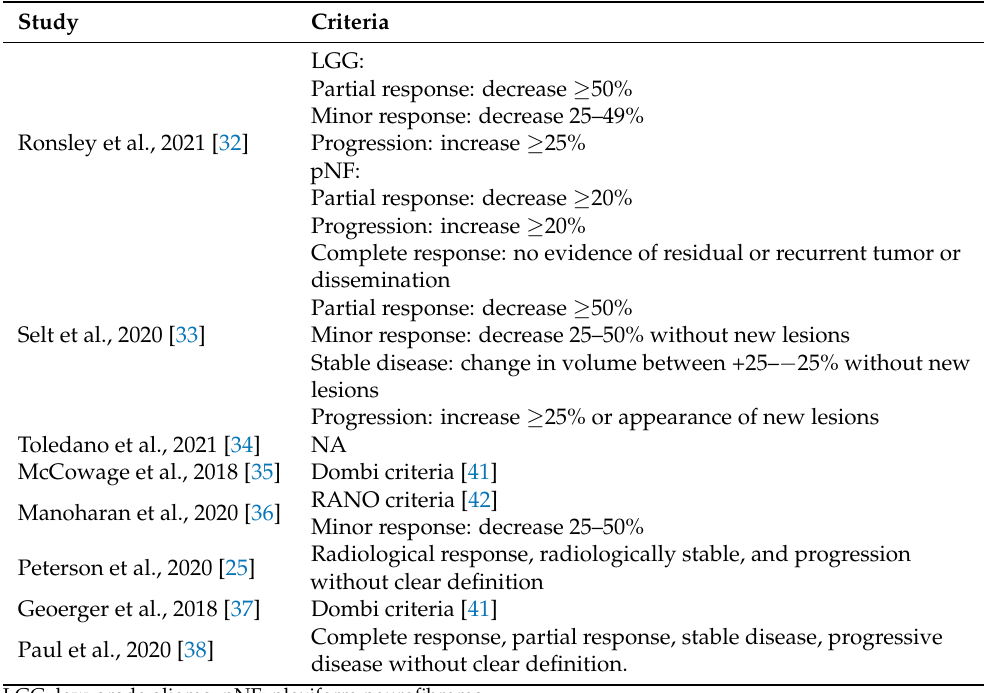
Table 2. Response criteria in included